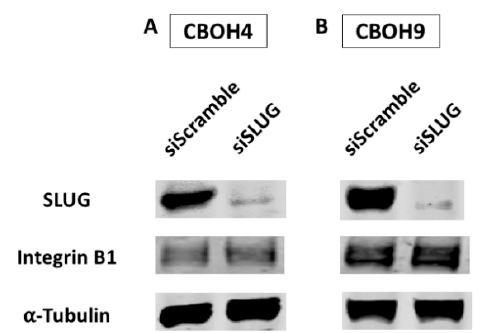
Figure 4. Knockdown of SLUG does not affect ITGB1 expression in CTCs. ( A , B ) Western blot analysis of ITGB1 protein expression levels when SLUG is transiently knocked down in CBOH4 and CBOH9. Expression was normalized against alpha-tubulin. Experiments were performed at least three times.